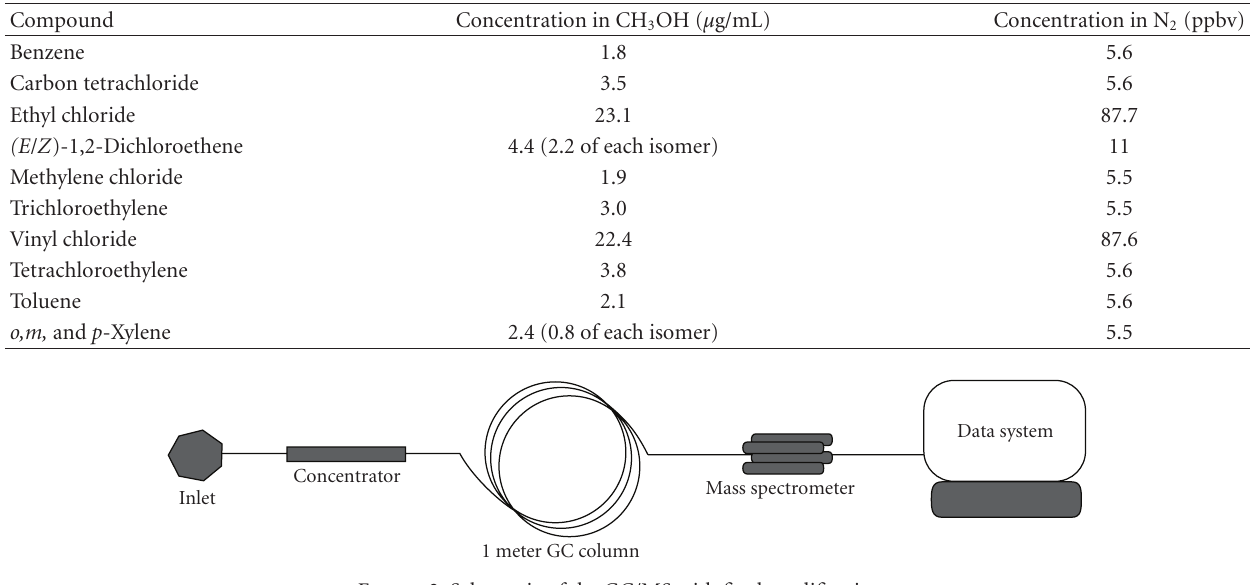
Figure 2: Schematic of the GC/MS with final